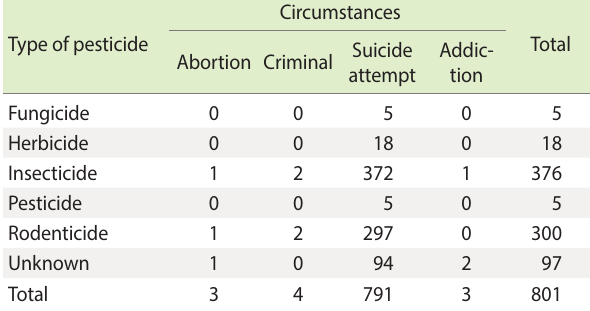
Table 3. Distribution of the types of pesticides used according to